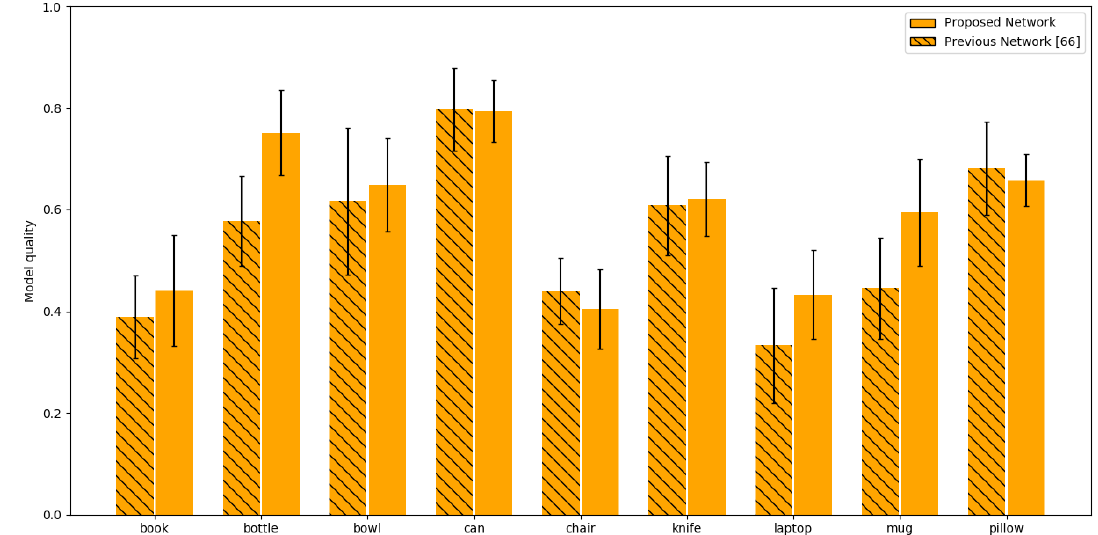
Figure 14. Comparison between the predicted object shape and ground truth using the IoU metric for different objects in the training set. The hashed bars denote the results achieved using the network proposed in [66]. The solid bars denote the results for the proposed